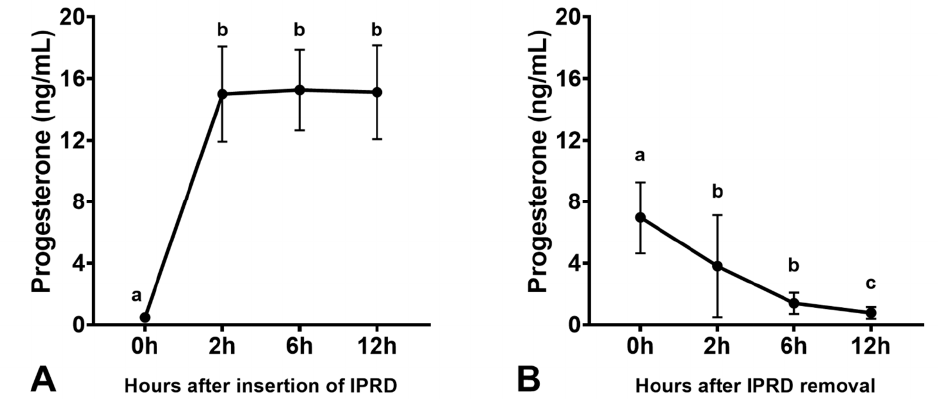
Figure 5. Serum progesterone concentration at 2, 6, and 12 h after insertion ( A ), and removal ( B ) of intravaginal progesterone-releasing device (IPRD) in acyclic mares (n = 12). Acyclic mares were treated with estradiol-17 β for 3 days and then given an IPRD (A, 0 h). The IPRD was kept for nine days and was then removed (B, 0 h). Different superscripts ( a,b,c ) denote effect of time ( p <